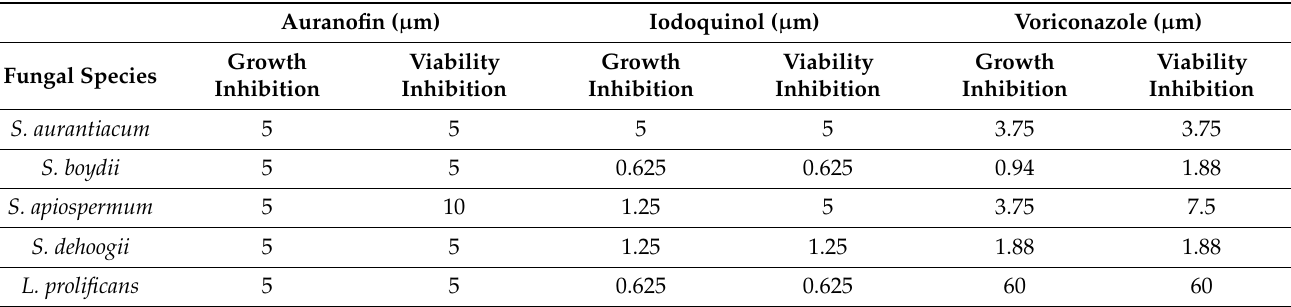
Table 2. Minimum inhibitory concentration of auranofin, iodoquinol and voriconazole against several Scedosporium and Lomentospora species.